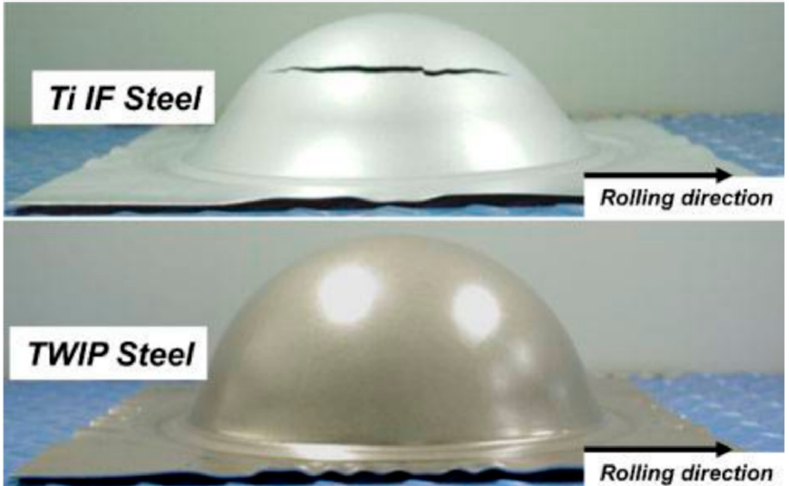
Figure 2. Comparison of Nakashima test samples for interstitial-free (IF) and TWIP steels [14]. (Reproduced with permission from refs. [14] . Copyright (2012), Taylor & Francis).